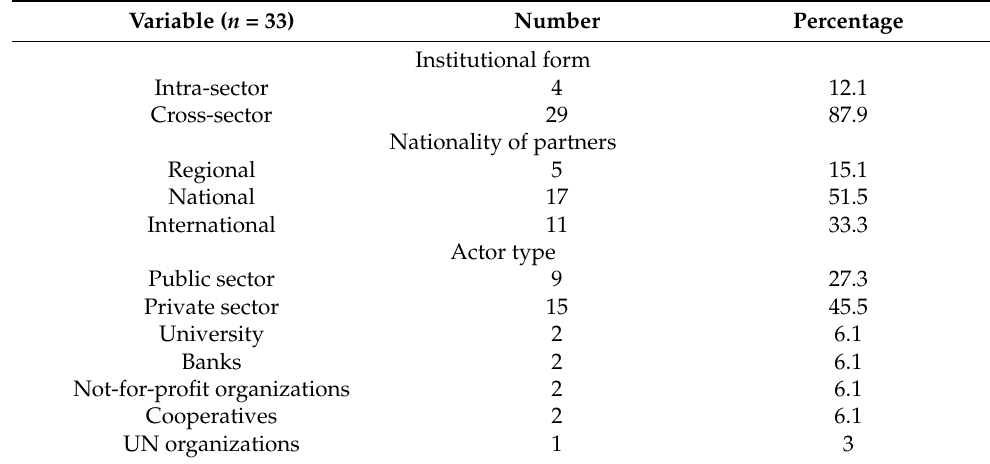
Table 4. Distribution of the partnerships according to the institutional form, nationality of the partners, and actor type.